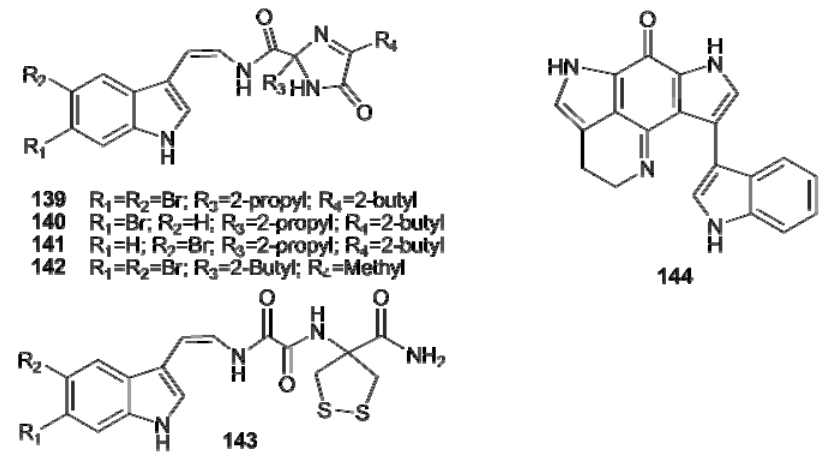
Figure 16. Structures of kottamides A–E ( 139–143 ) and wakayin ( 144